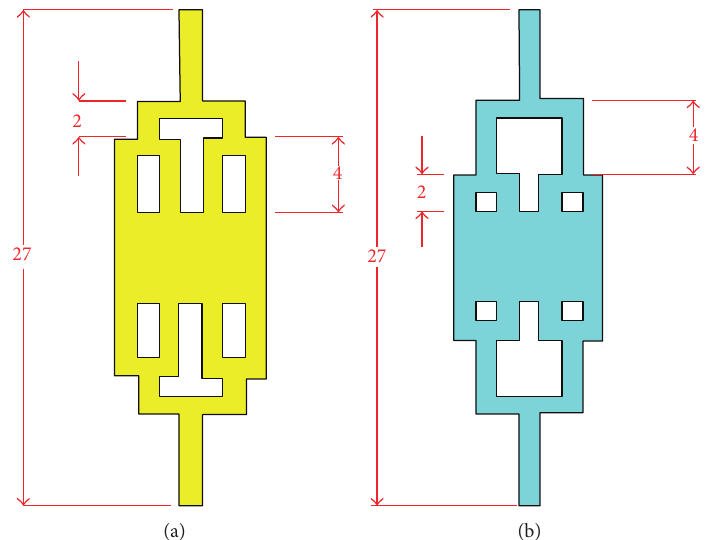
Figure 5: Schematic of (a) microfluidic platform architecture with subchannel length ratio of 1: 2; (b) microfluidic with subchannel length ratio of 2 :